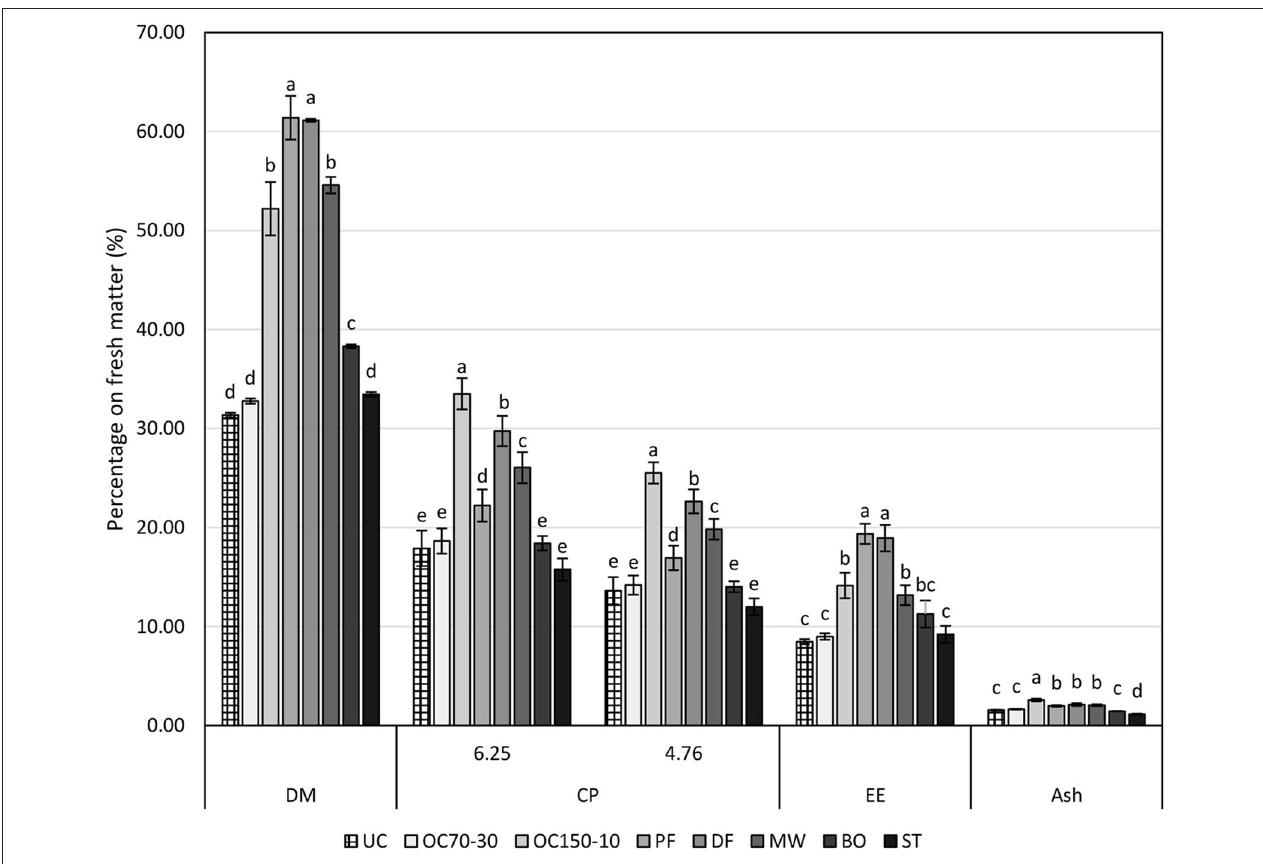
FIGURE 2 | Proximate compositions (on fresh matter, %) of uncooked larvae and larvae cooked with different techniques. DM, dry matter; CP, crude protein (protein-to-nitrogen conversion factors of 6.25 and 4.76); EE, ether extract; UC, uncooked; OC70-30 oven cooked at 70 ◦ C for 30min; OC150-10, oven cooked at 150 ◦ C for 10min; PF, pan fried (30ml oil per 100g of larvae, 2min); DF, deep fried (300ml of oil per 100g of larvae, 2min); MW, cooked in microwave (800W per 150s); BO, boiled (plastic bag under vacuum for 30min); ST, steamed for 10min. Different letters show statistically significant differences among samples for each